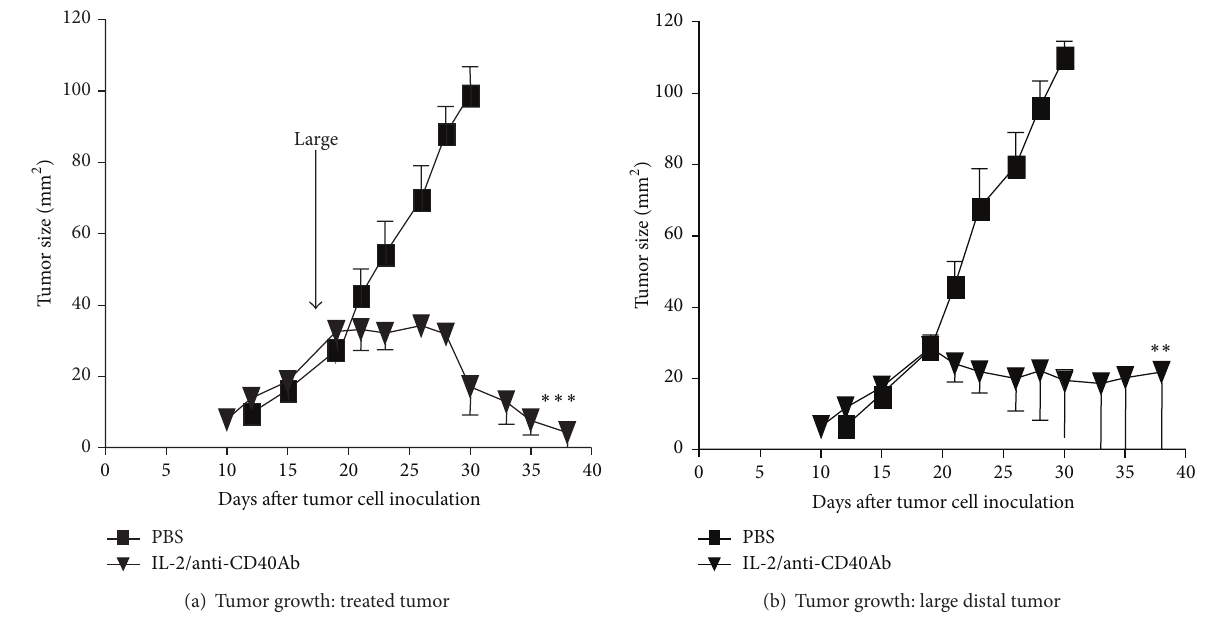
Figure 2: Animal study showing how intratumoral therapy induces local regression plus distal regression of uninjected tumor. Intratumoural IL-2 + anti-CD40 is an effective combination against local tumour and untreated distal tumours. C57Bl/6J mice were injected s.c. with 5 × 10 5 AE17 tumour cells into the left flank and 5 × 10 5 AE17 cell into the right flank on day 0 and left to develop into large tumours before treatment began. The i.t. treatments were delivered into one tumour indicated by arrows (treated tumour: a), whilst the second (distal) tumour was left untreated (b). Data from 1 experiment (5 or 6 mice/group) is shown as mean ± SEM. Treated mice were compared to PBS-treated controls mice; ∗∗ 𝑃 < 0.01 , ∗∗∗ 𝑃 < 0.001 (from Jackaman et al., 2008. International Immunology)